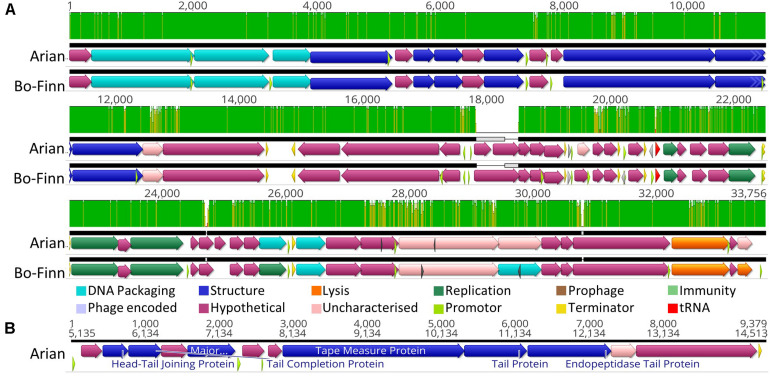
Analysis of the Butyrivibrio phage Arian and Bo-Finn genomes. (A) Mauve alignments (Darling et al., 2004) of the two genomes showing annotated ORFs, with directionality and function according to color. Nucleotide similarity is expressed as a graph, with green indicating 100%, yellow > 30%, red < 30%. (B) The organization of the tail morphogenesis module in phage Arian. Uncharacterized proteins indicate where the protein was homologous to one reported previously, but had an unknown function, whereas hypothetical proteins did not show similarity above the set thresholds to any known proteins. Phage encoded proteins are those where there was uncertainty about their function.